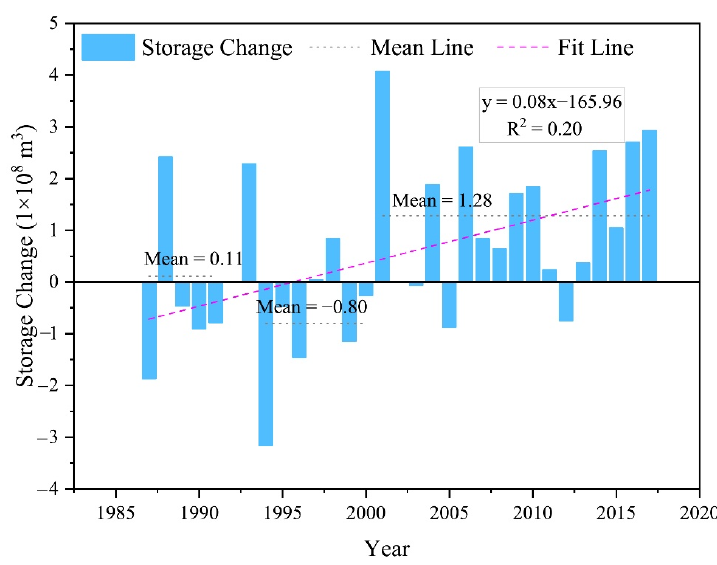
Figure 5. The storage change of Hala Lake during 1987–2018.